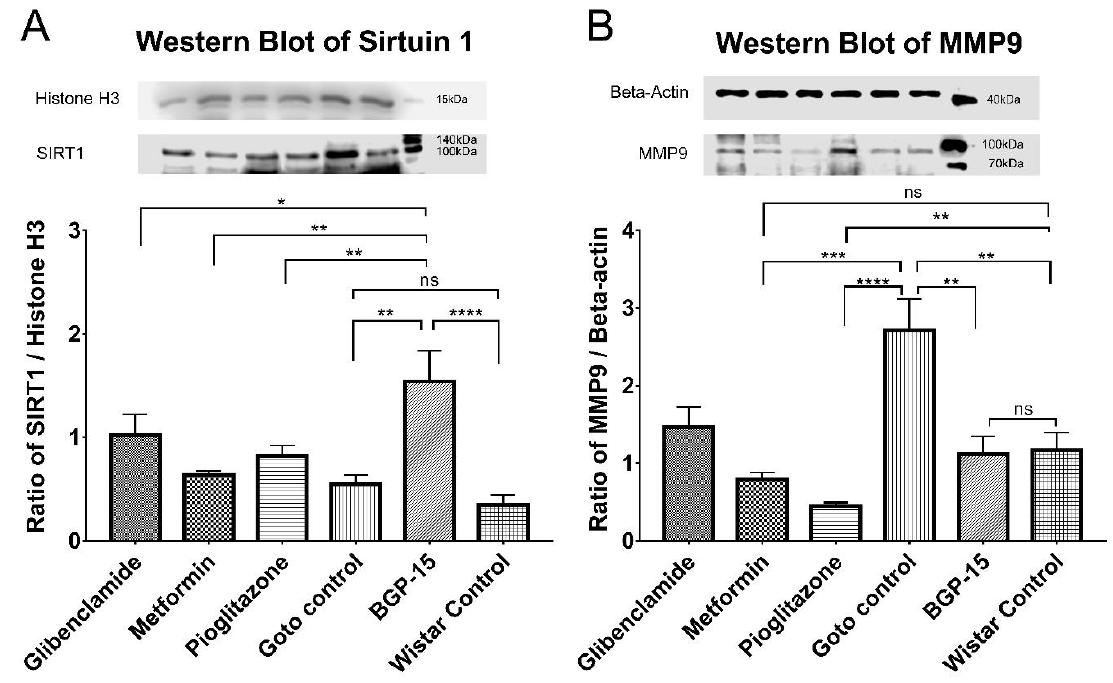
Figure 10. Western Blot results. ( A ) Expression levels of Sirtuin 1 (SIRT1) in the di ff erent groups of the study. ( B ) Expression levels of Matrix metalloproteinase 9 (MMP9) in the di ff erent groups. Detected proteins: Histone H3 (~17kDa), SIRT1 (~120kDa), beta-actin (~42kDa), MMP9 (~92kDa). All data